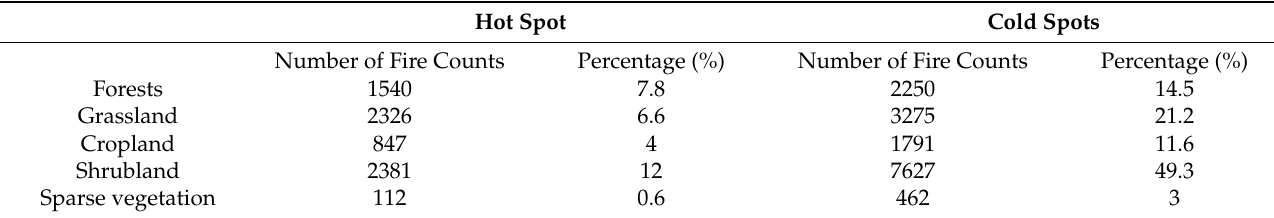
Table 5. Distribution of fire intensity in vegetation